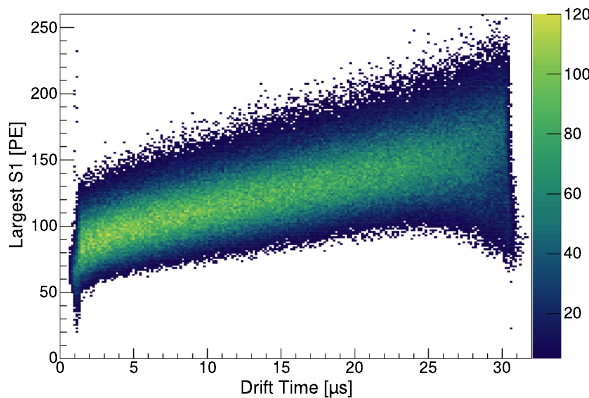
between June 2019 and March 2020, with the dashed lines